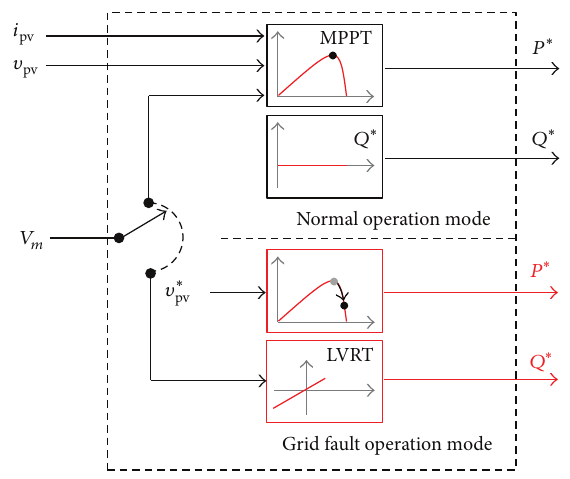
Figure 7: Power profiles for a single-phase grid-connected PV system in different operation modes.